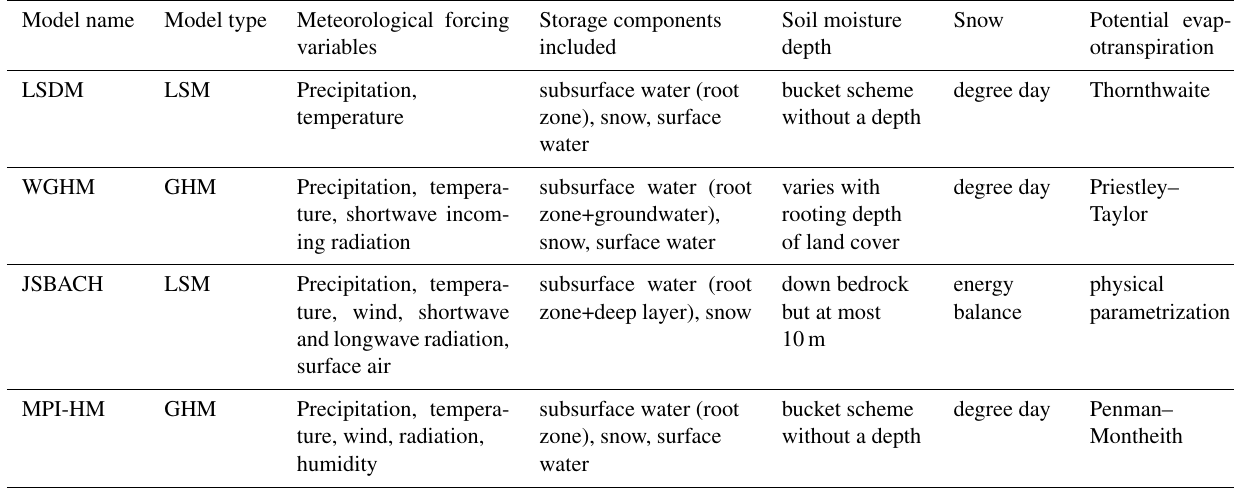
Table 1. Overview of the main characteristics of the four numerical models particularly considered in this study. Model